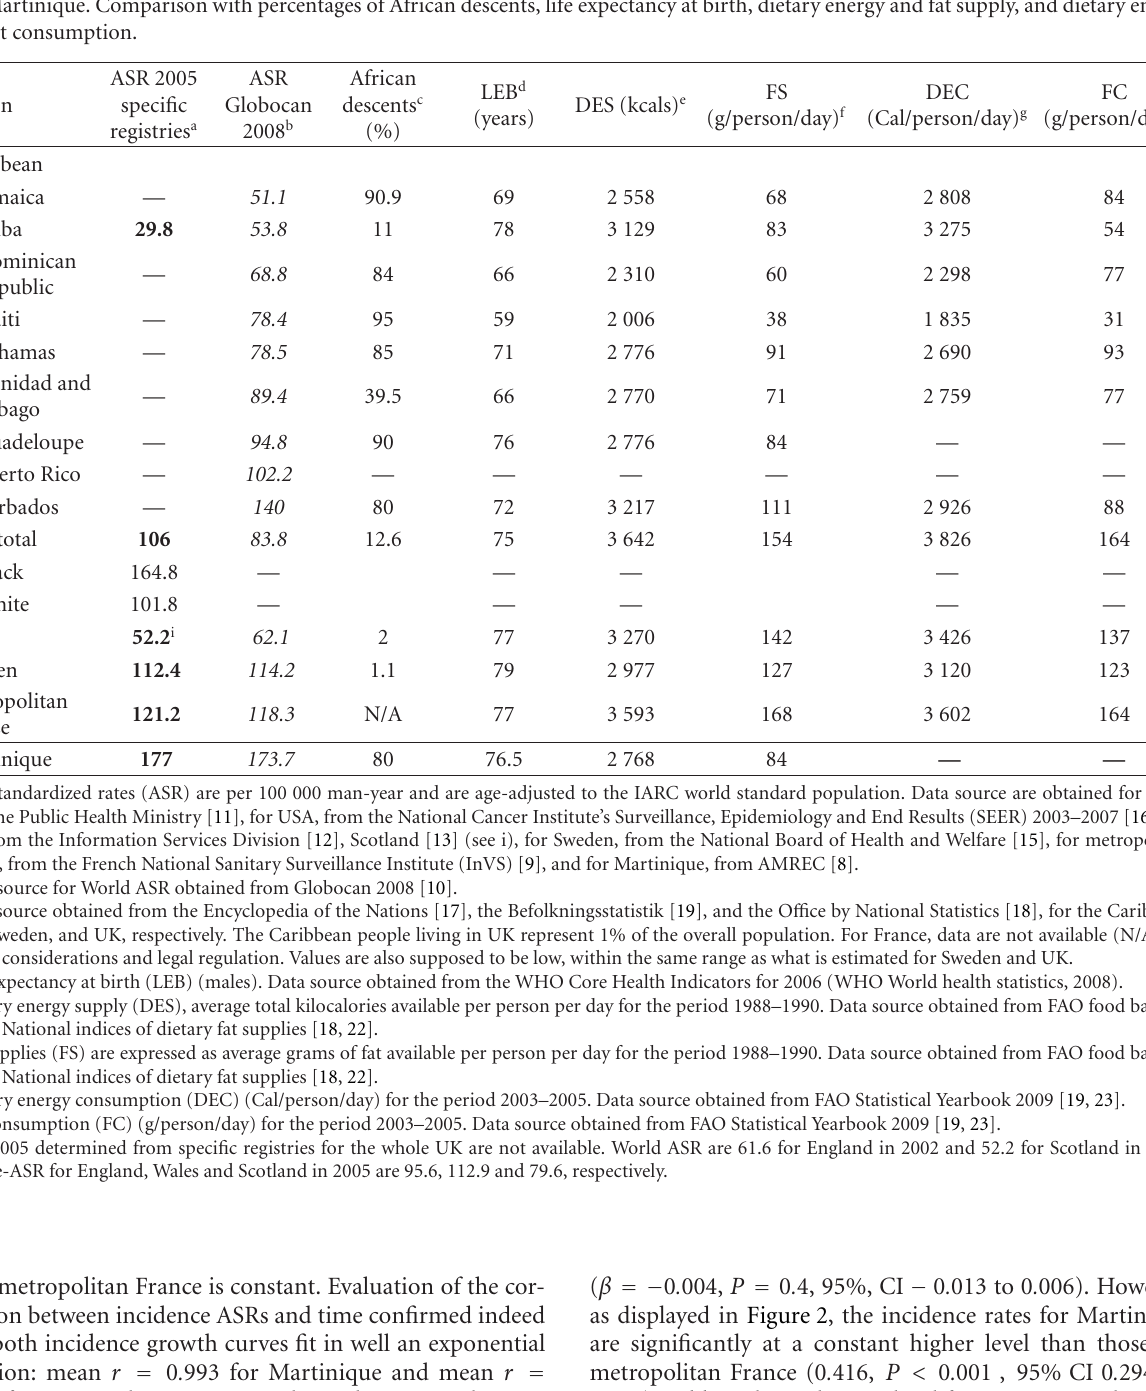
Table 1: World age-standardized incidence rates (ASRs) of prostate cancer in 2005 in Caribbean, USA, UK, Sweden, metropolitan France, and Martinique. Comparison with percentages of African descents, life expectancy at birth, dietary energy and fat supply, and dietary energy and fat consumption.